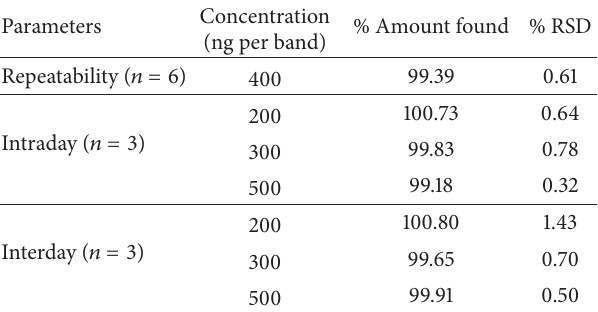
Table 1: Repeatability and intraday and interday precisions.